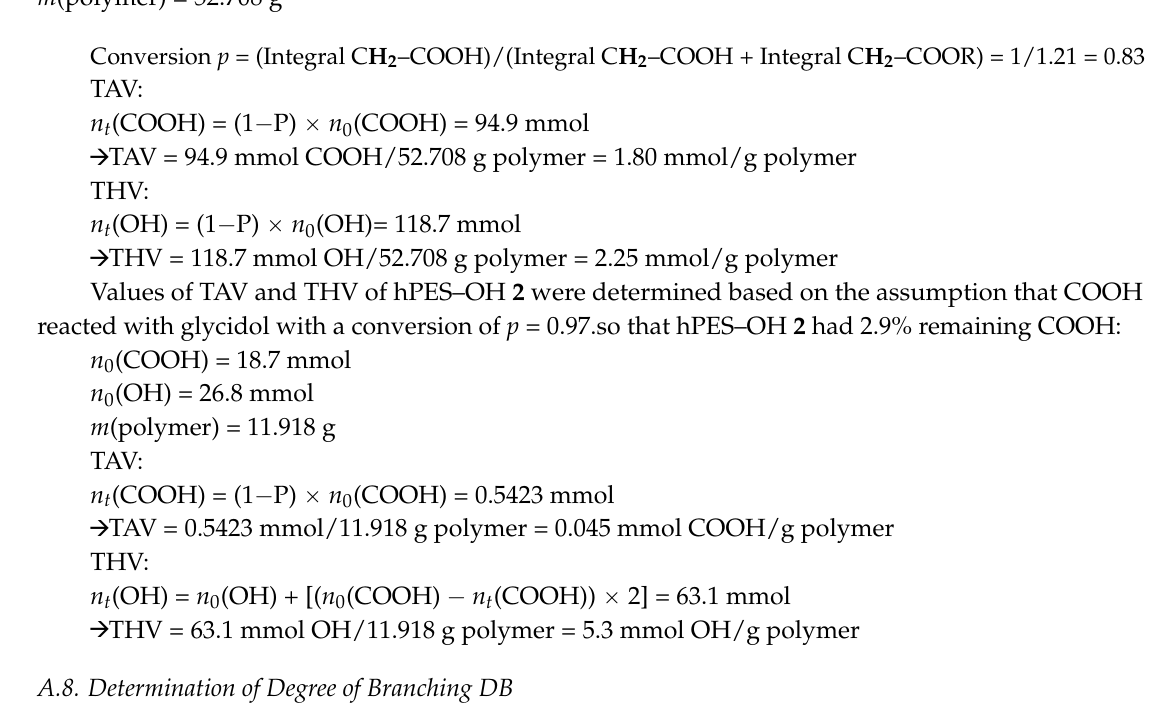
Table A2. Interpretation of inverse-gated (IG) 13 C NMR spectra of hyperbranched polyesters in DMSO-d 6 . Integral values of –CH– signals of relevant glycerol units for evaluating the degree of branching (DB).